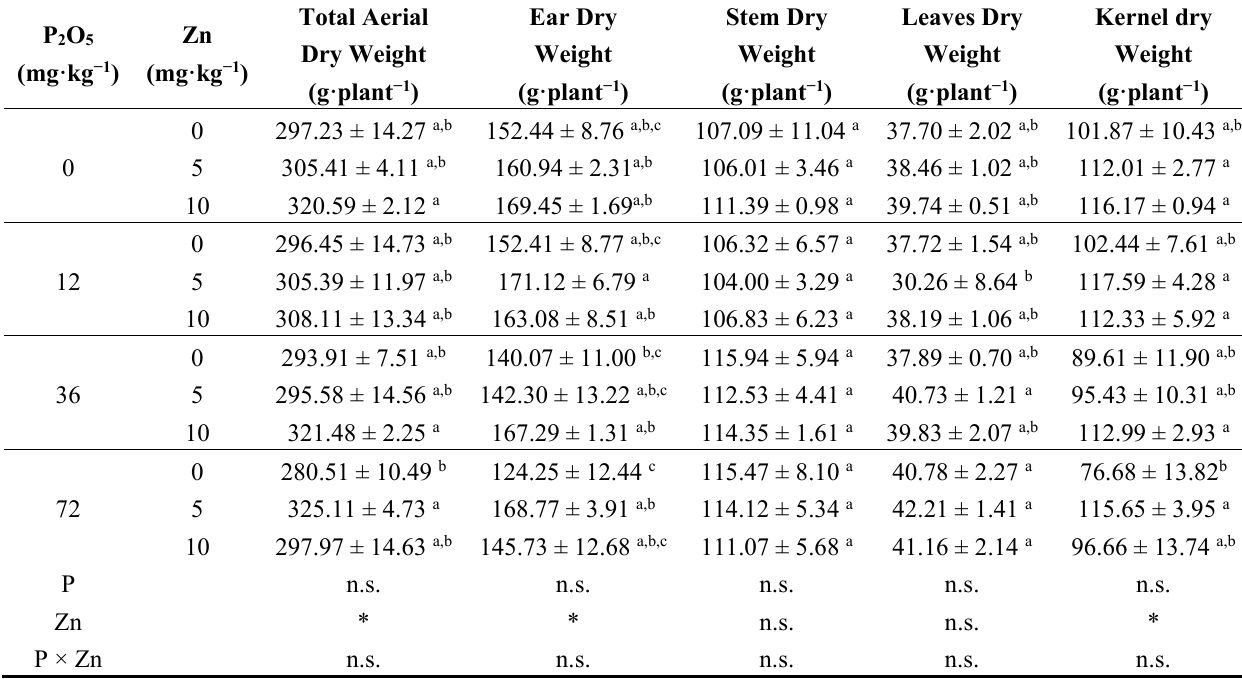
Table 3. Effect of zinc and phosphorus supply on shoot dry weight of corn silage at harvest and its partitioning into stem, leaves, ear and